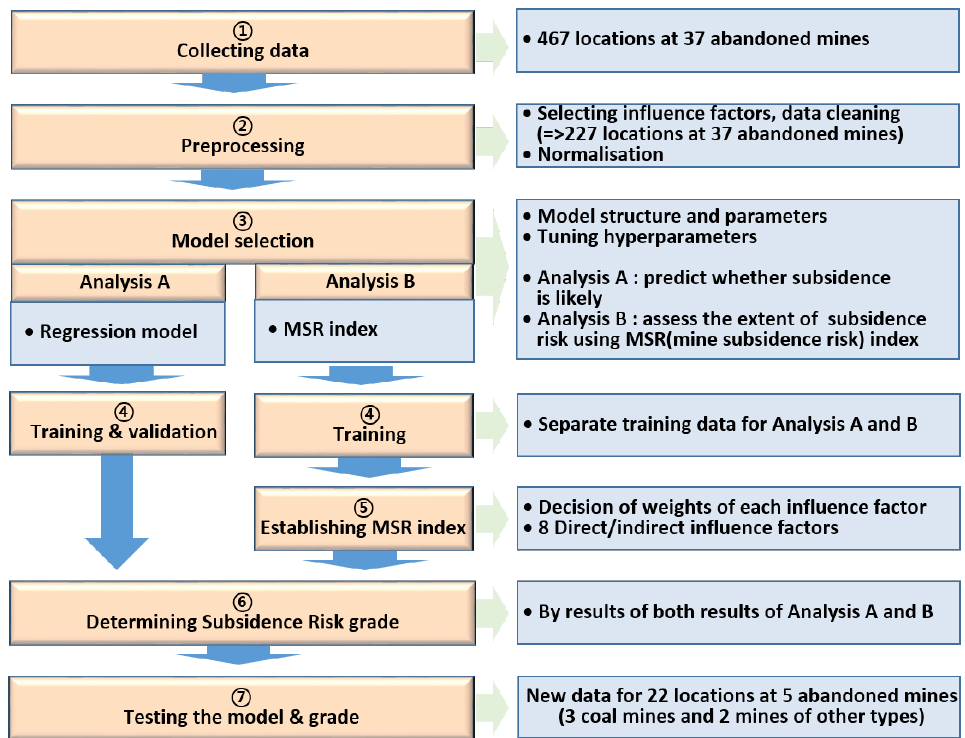
Figure 2. Study Figure 2. Study process .